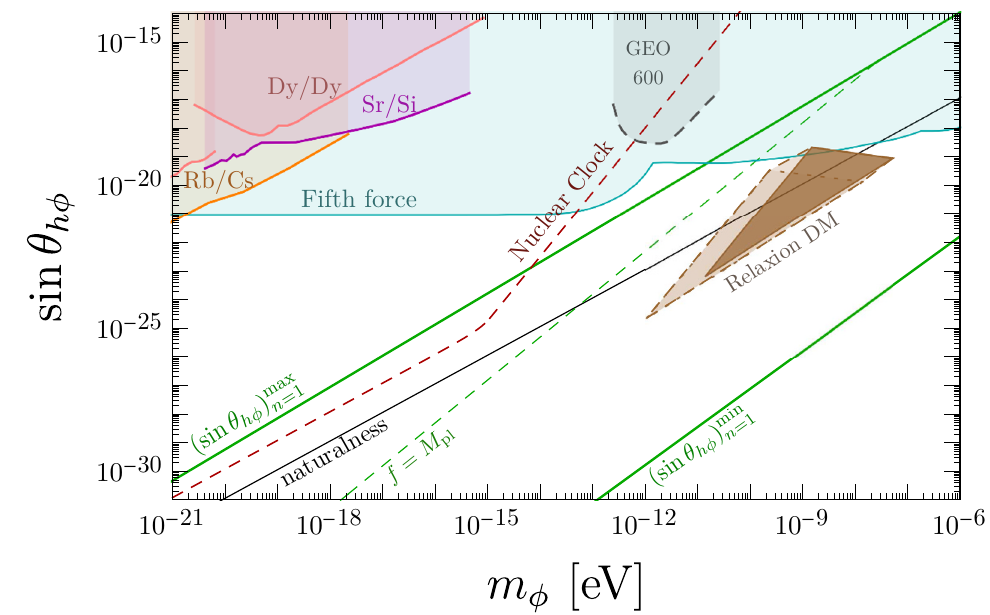
Figure 5 . A relaxion window and the available parameter space for the light relaxion. The green lines are the maximum and minimum mixing angle at n = 1, while the black line corresponds to the naturalness line, sin (cid:18) h(cid:30) m (cid:30) =v . If one requires f to be sub-Planckian, the mixing angle EW (cid:24) should be smaller than the green dashed line. The (cid:12)fth force constraints [61, 63], represented as turquoise shaded region, provide stringent constraints over the mass scale shown in the (cid:12)gure. The relaxion constitutes the entire dark matter in the universe in the brown shaded region, while it only constitutes > 1% of the dark matter in the light shaded region. This DM parameter space is obtained by projecting the relaxion dark matter parameter space for all available (cid:3) onto this two dimensional parameter space. The existing atomic clock bounds, using Dysprosium (pink) [64], Rubidium- Cesium (orange) [65], and Strontium-Silicon cavity (magenta) [66], are also shown. Interferometry can also be used to probe dark matter, and the projected sensitivity of GEO 600 experiment is shown as gray dashed line [12]. Finally, we show the projected sensitivity of nuclear clock as a red dashed line. See the main text for